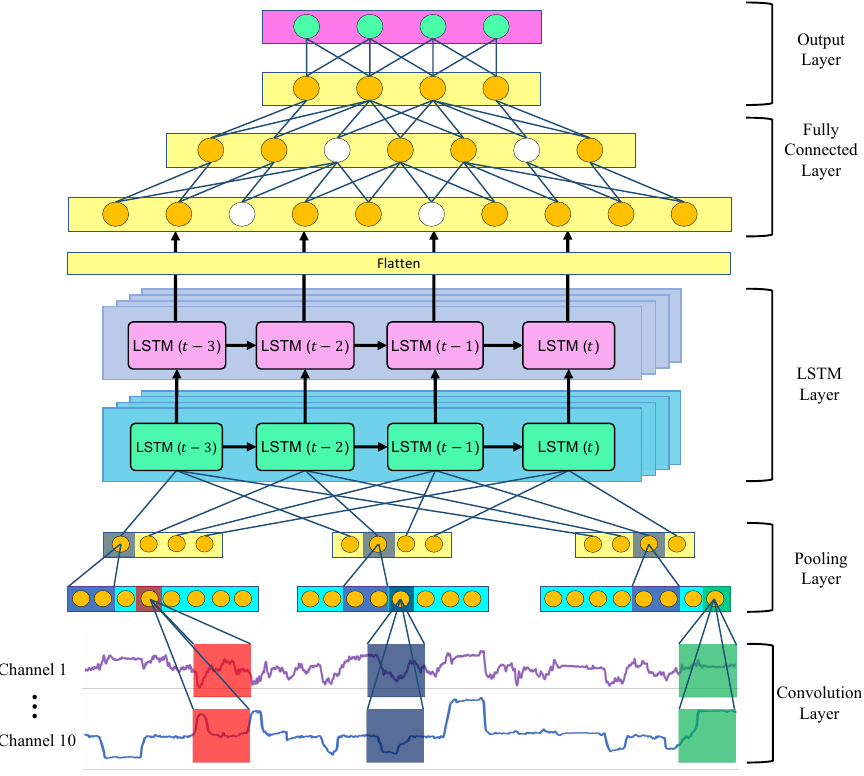
Figure 6. Architecture of the